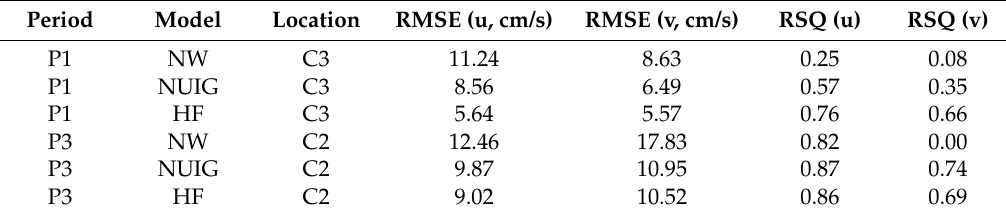
Table 4. Statistics between models and